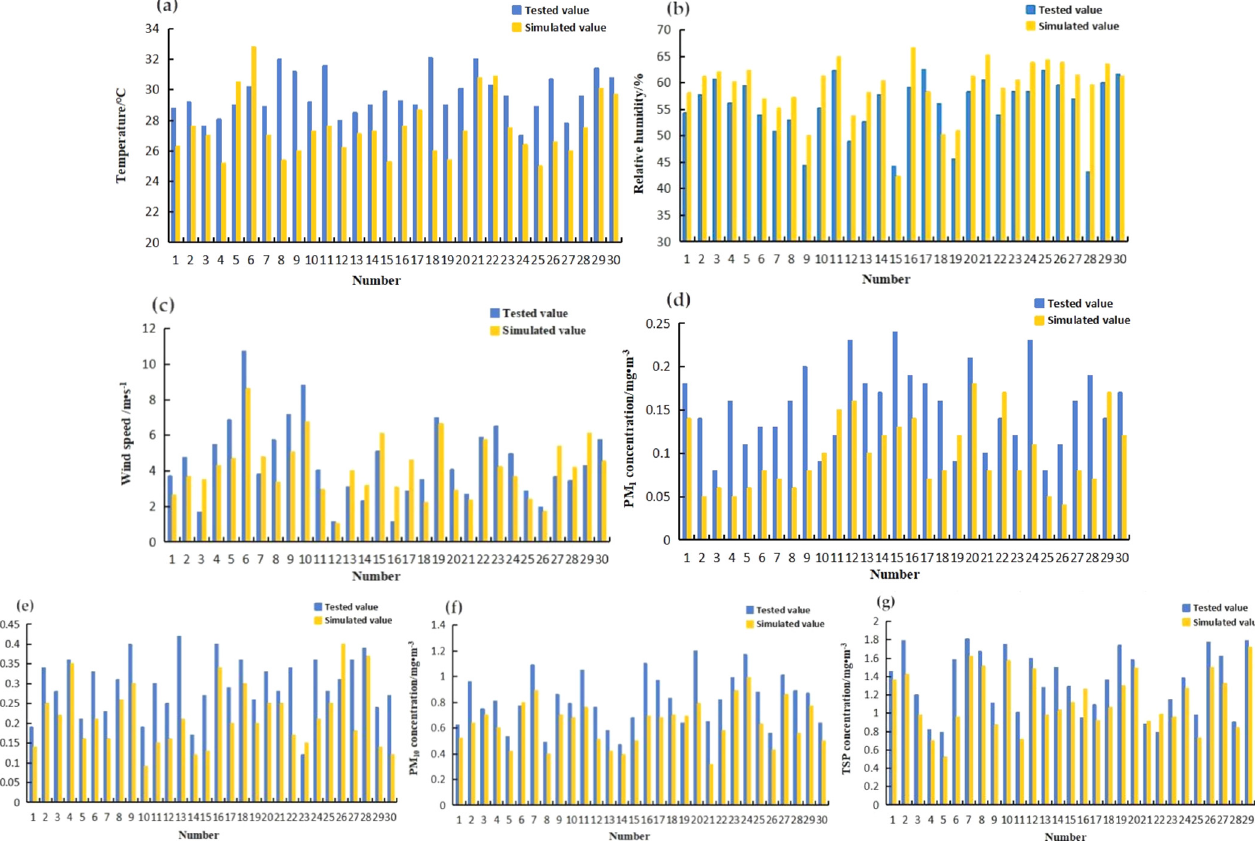
Figure 4. Measured value compared with simulated value: ( a ) temperature; ( b ) relative humidity; ( c ) wind speed; ( d ) PM 1 ; ( e ) PM 2.5 ; ( f ) PM 10 ; and ( g ) TSP (outside).